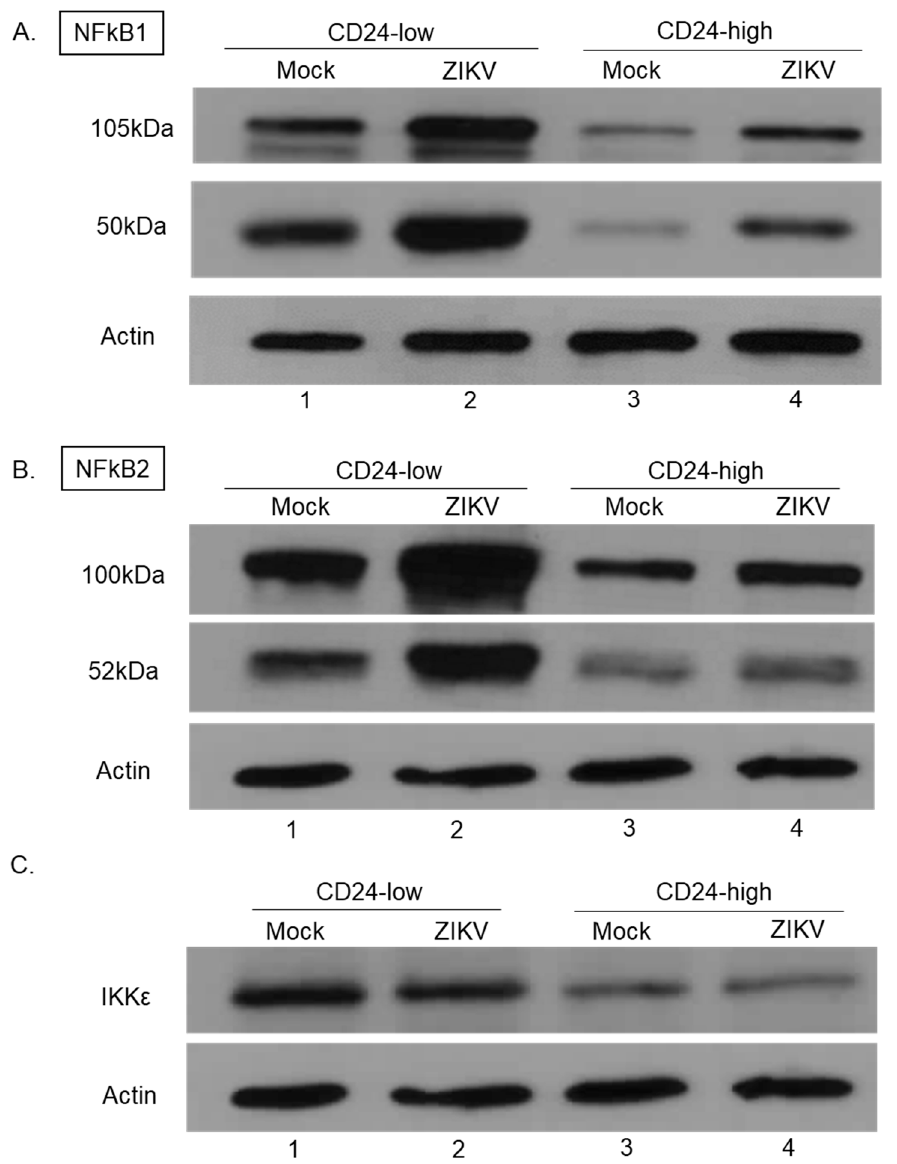
Figure 6. The expression of NF κ B1, NF κ B2, and IKK ε differs between CD24-low and CD24-high cells. Cells were either mock- or ZIKV-infected at MOI of 5 for 18 h. Total levels of ( A ) NF κ B1 (p105/p50), ( B ) NFkB2 (p100/p52), ( C ) IKK ε , and actin were analyzed via Western blotting.